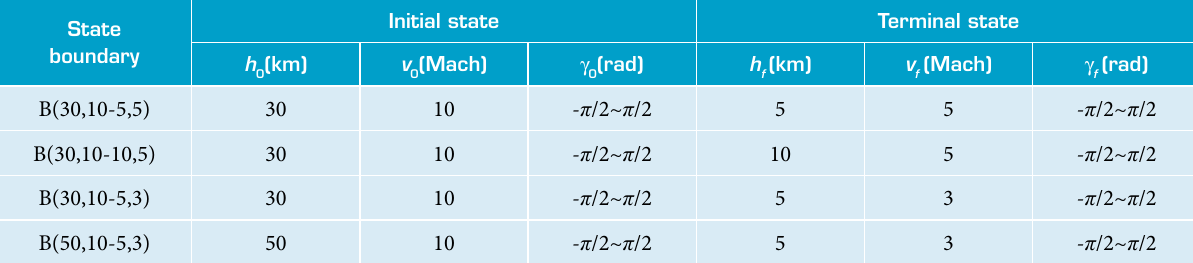
Table 3. The values of two-point boundary for the unpowered trajectory